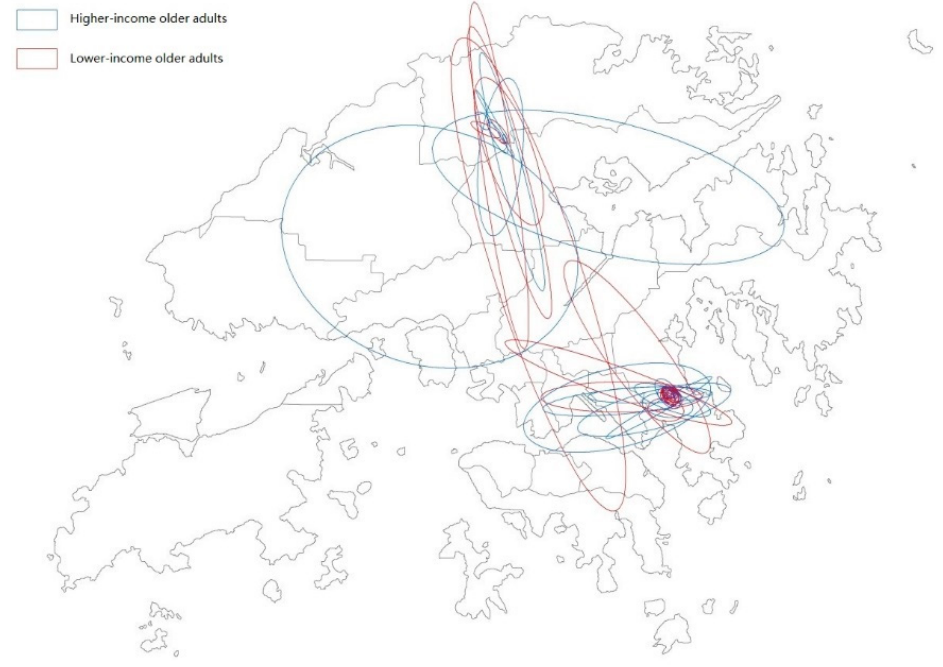
Figure 2. Participants’ residential places and extensity pattern based on SDE. Table 3. Comparison of activity spaces between lower- and higher-income older adults.